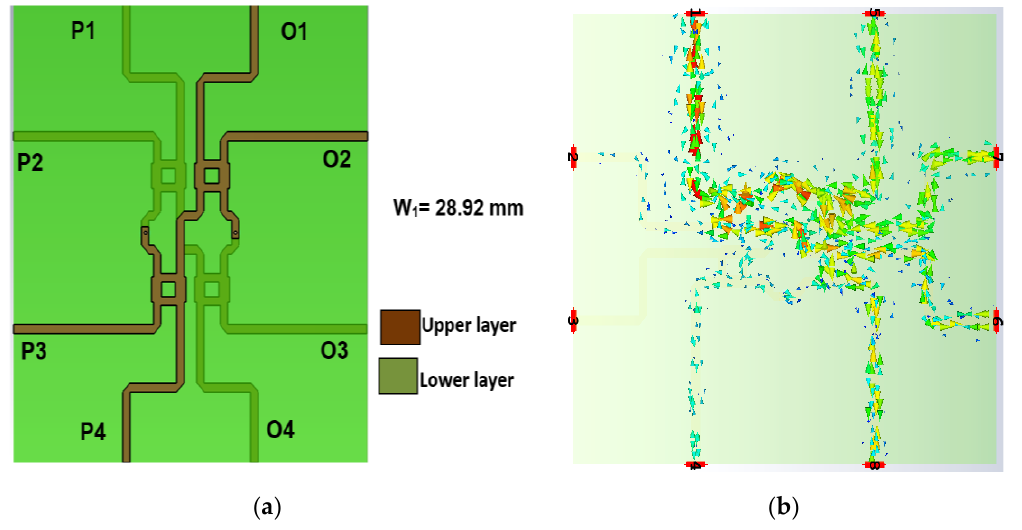
Figure 16. Butler matrix internal design: ( a ) top view and ( b ) surface current distribution. Table 2. Via- hole with reference ‘ A ’ dimensions and output phases.